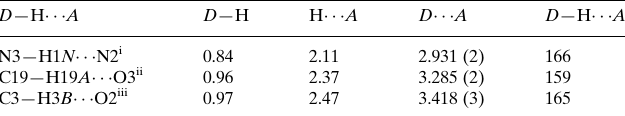
Hydrogen-bond geometry (A˚ , (cid:2)